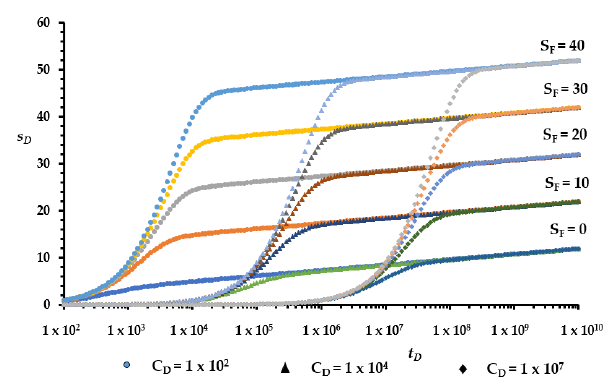
Figure 4. Demonstration of dimensionless drawdown s D vs. log t D (for the selected values, S F and C D ).